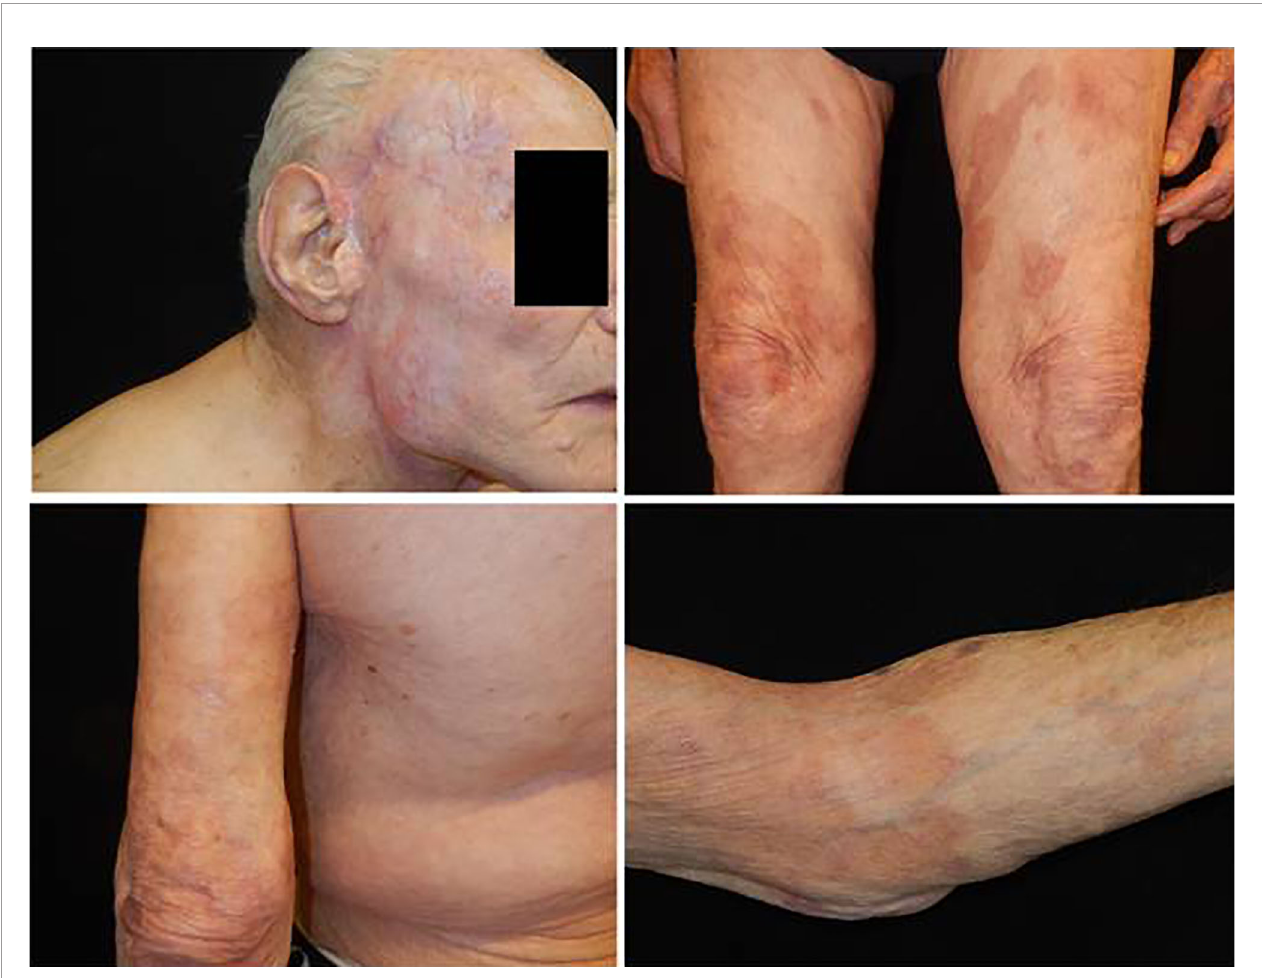
FIGURE 3 | Complete remission of cutaneous squamous cell carcinoma on the head, and absence of bullous lesions on the trunk and the